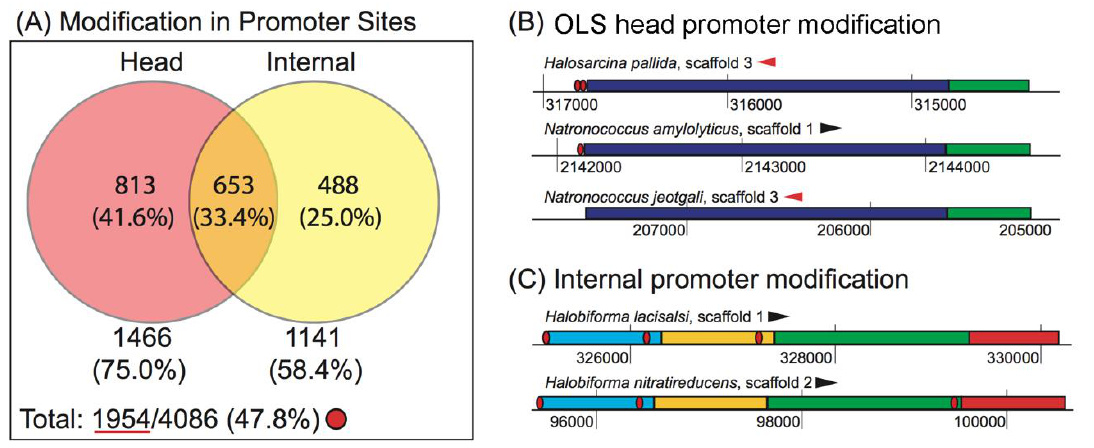
Figure 6. OLS modification by promoter. ( A ) Observed modifications in promoter sites. A total of 1954/4086 identical content groups (red circle) exhibit a modification in promoter content. Content groups that exhibit a modification (1954, red underline), were assessed for the location of the modification, if it occurred at the head of the OLS, an internal site, or both (Venn diagram). Two examples are shown: ( B ) a modification at the OLS head only and ( C ) modification at internal site(s) only. In ( B ), the blue gene is 3-hydroxyacyl-CoA dehydrogenase, green gene is a monoamine oxidase regulatory protein. In ( C ), blue, yellow, green, and red genes are a spemidine-binding ABC transporter, PotA, PotB, and aliphatic amidase, respectively.